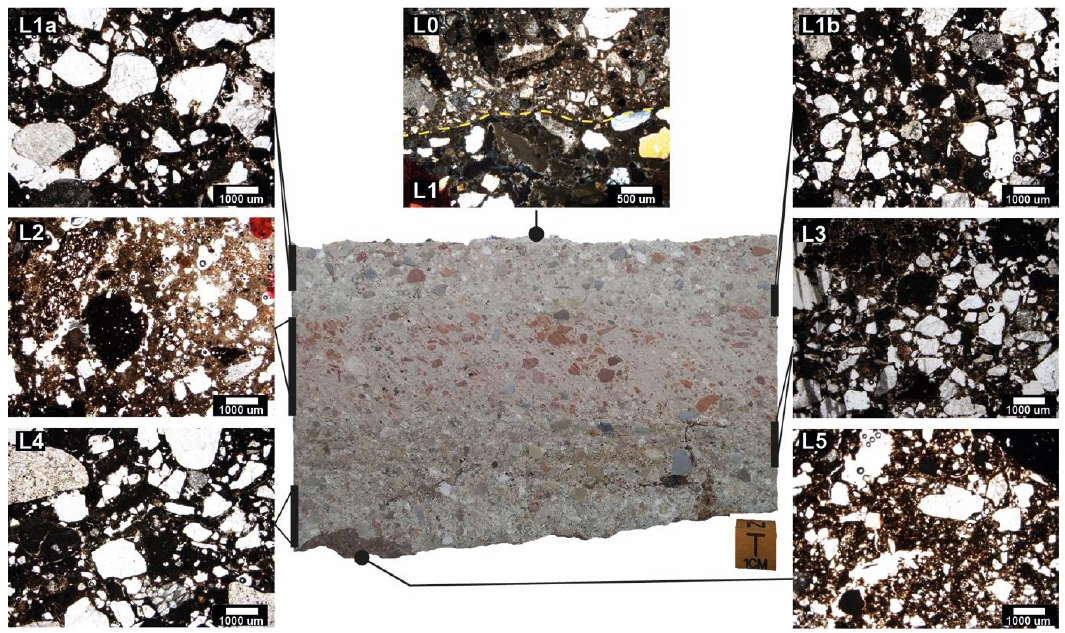
ff erent layers (L0–L6) in the AD-124 wall Figure 3. Photomicrographs of the different layers (L0–L6) in the AD-124 wall mortar. Figure 3. Photomicrographs of the di